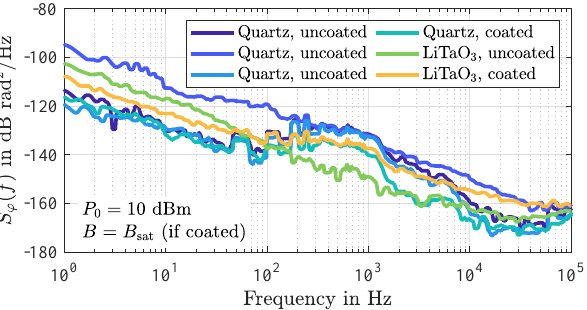
Figure 9. Measured power spectral densities of random phase fluctuations of several delay lines of basically the same design but from different wafers. The significant variance between the measured noise floors indicates differences in the purity of the materials that cause fluctuations in the local acoustic wave velocity. The labels coated and uncoated refer to the presence of a magnetostrictive layer. The measurements were performed at an electrical input power level of 10dBm and without any additional